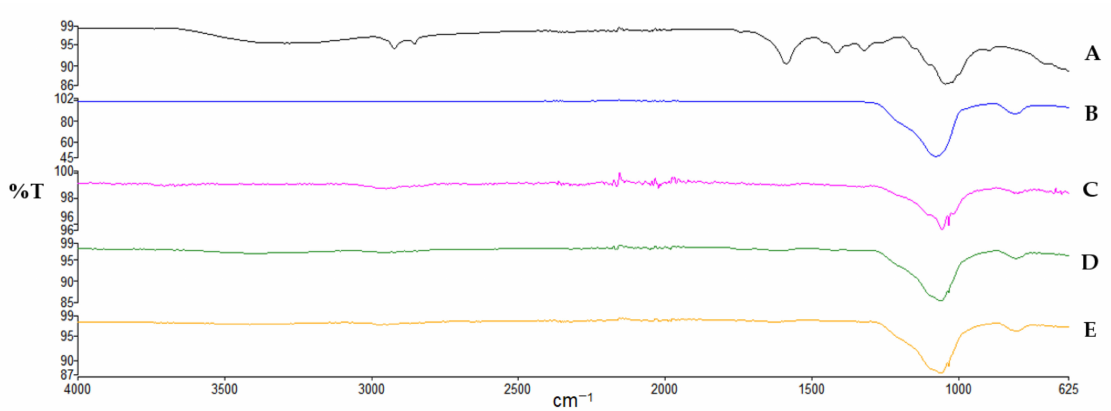
Figure 2. IR spectra of (A) CMC, (B) SiO 2 and CMC-SiO 2 conjugates prepared in ratio; (C) 1:1, (D) 1:2.5 and (E)